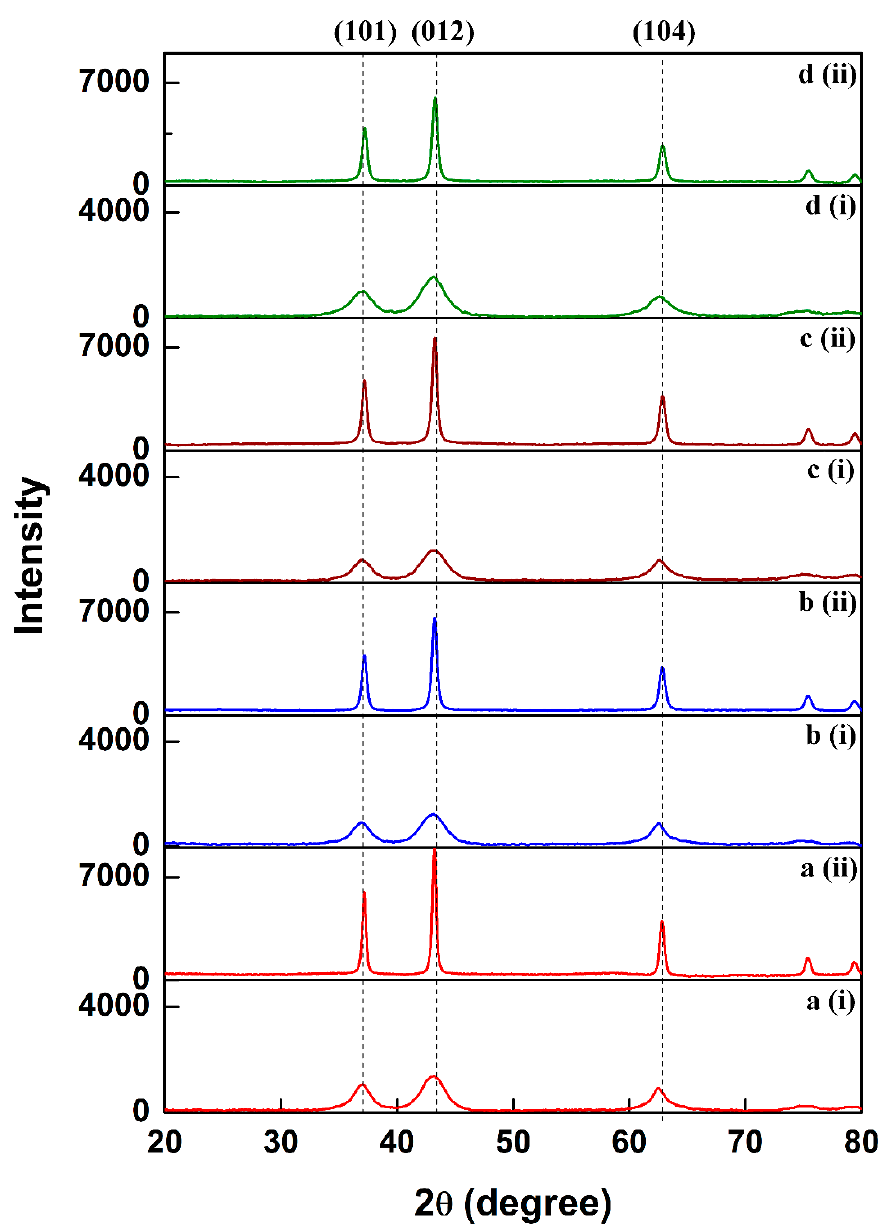
Figure 1. X-ray diffractogram of ( a ) NaOH-, ( b ) aloe-vera-, ( c ) dragon-fruit- and ( d ) papaya-extract- mediated NiO x nanoparticles calcined at ( i ) 300 ◦ C and ( ii ) 600 ◦ C. The average crystal sizes ( D ) were calculated based on the width of the peak due to the (200) planes by using the Scherrer’s formula